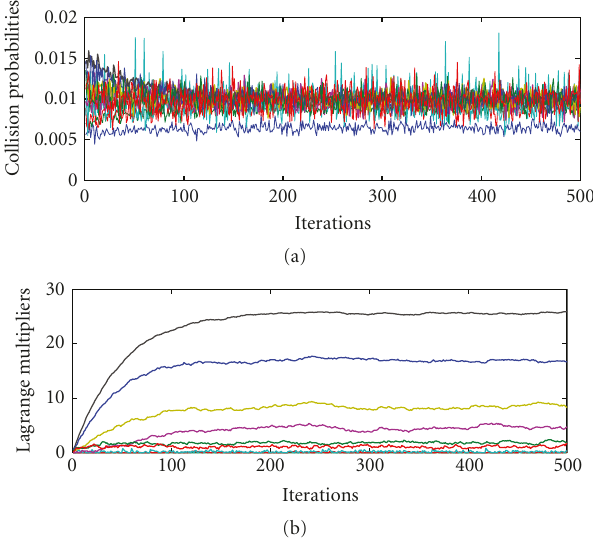
Figure 5: The ratio of the average throughput achieved to the genie- aided